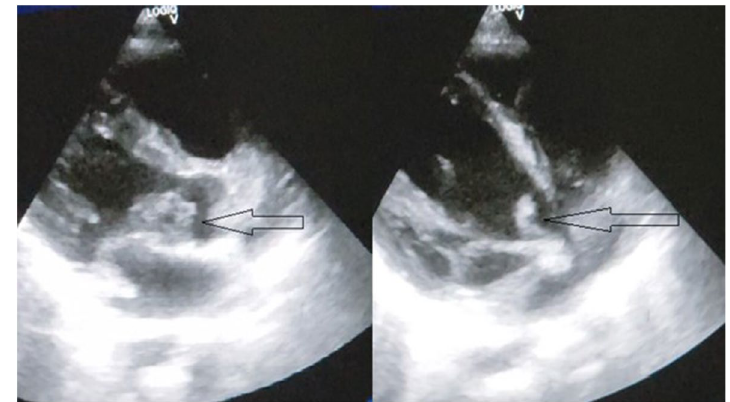
Fig. 2 Echocardiography images showing vegetations over the mitral